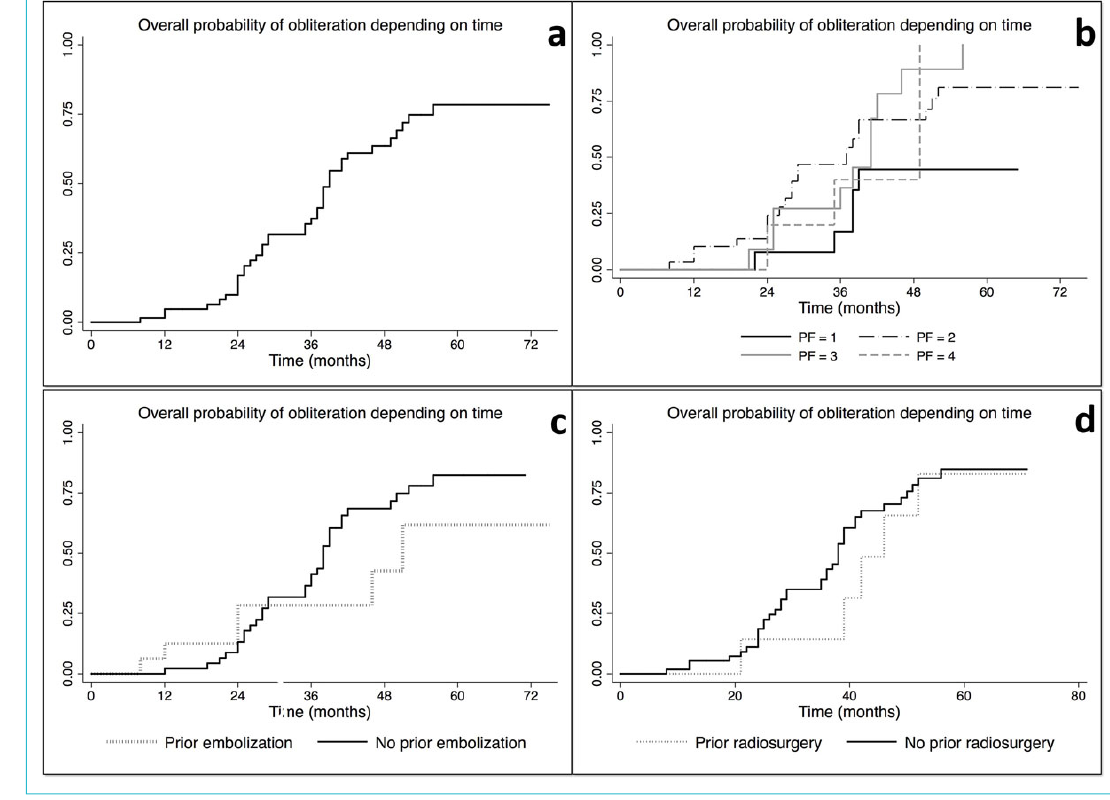
Figure 3: Kaplan-Meier curves showing: (a) the overall probability of obliteration over time; (b) the overall probability of obliteration by Pollock- Flickinger score; (c) the overall probability of obliteration by prior embolisation versus no prior embolisation (p <0.05); (d) the overall probability of obliteration by prior radiosurgery versus no prior radiosurgery (p >0.05).